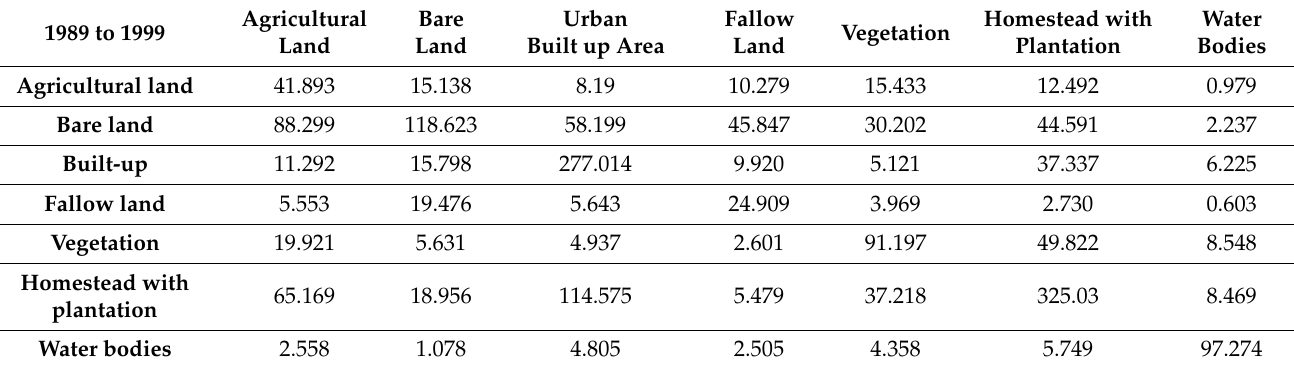
Table 14. Transition matrix (1989 to 1999).